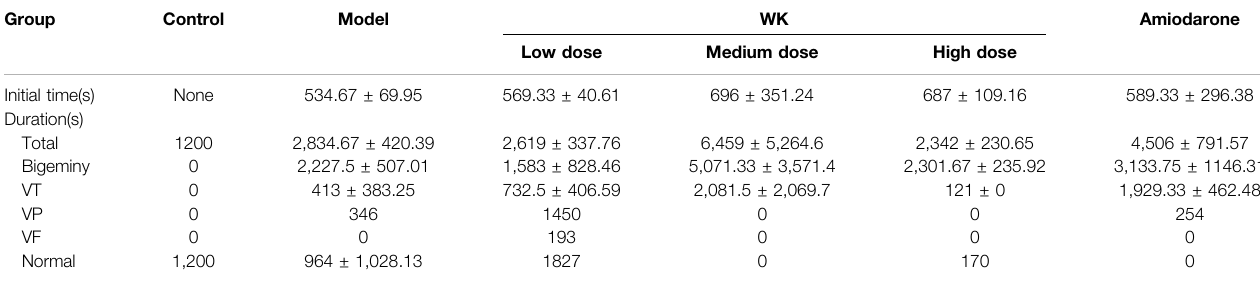
TABLE 4 | The initial time and duration of arrhythmias ( x ± s , n (cid:1) 8). Group